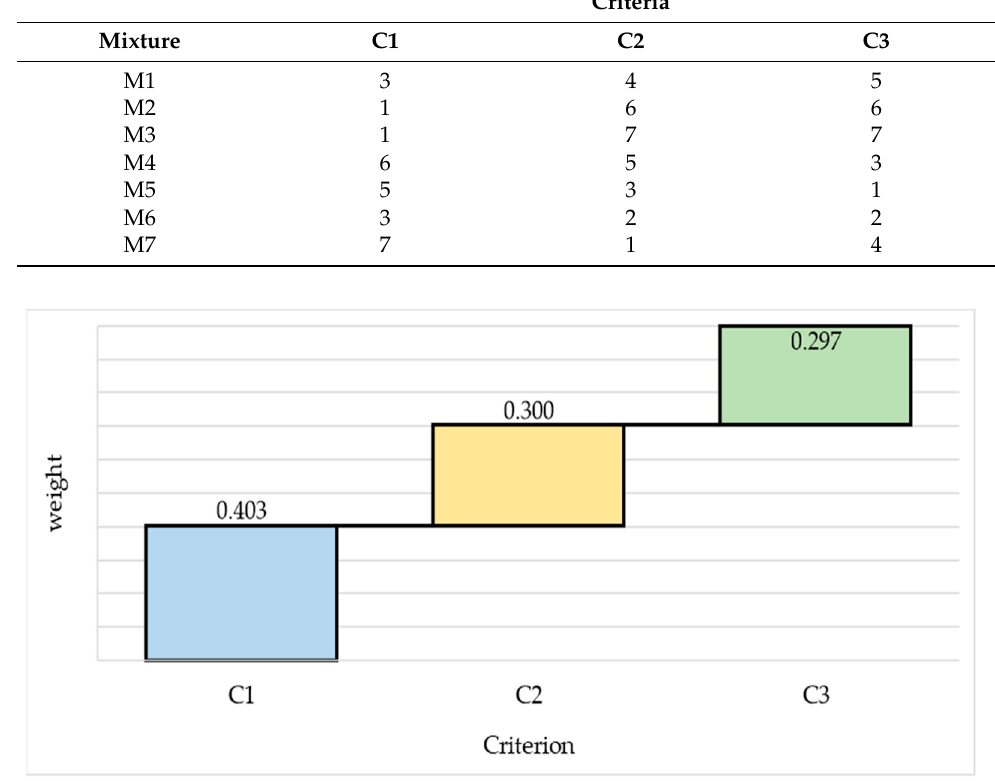
Figure 7. Criteria weights obtained using the MEREC method.